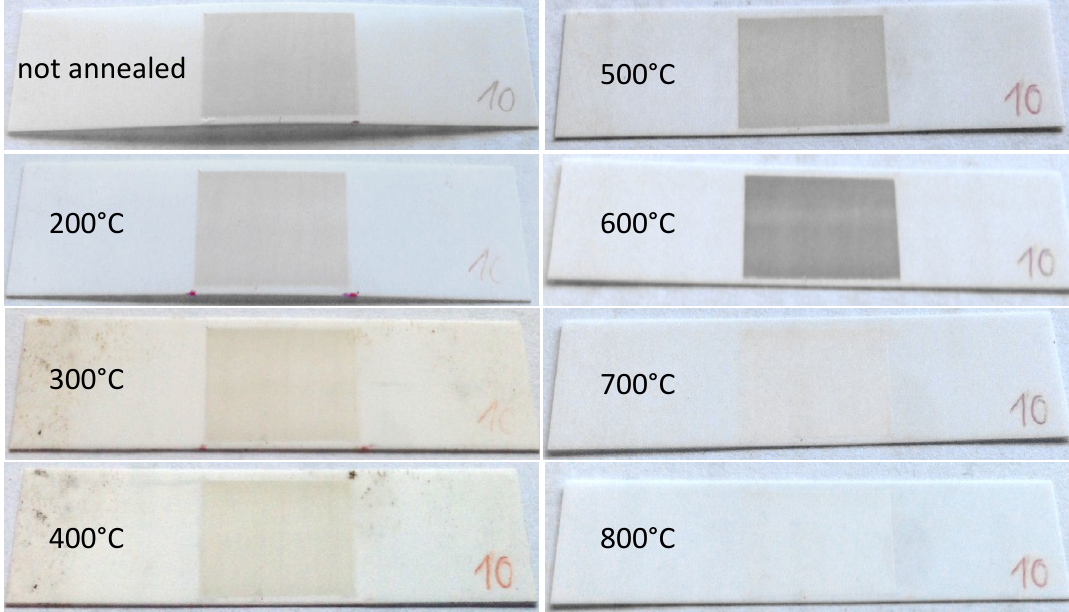
Figure 7. AD Al O coated alumina substrate annealed in 100 °C steps from 200 °C to 2 3 800 °C. Deposition parameters: 100% N , film thickness t ≈ 9 2